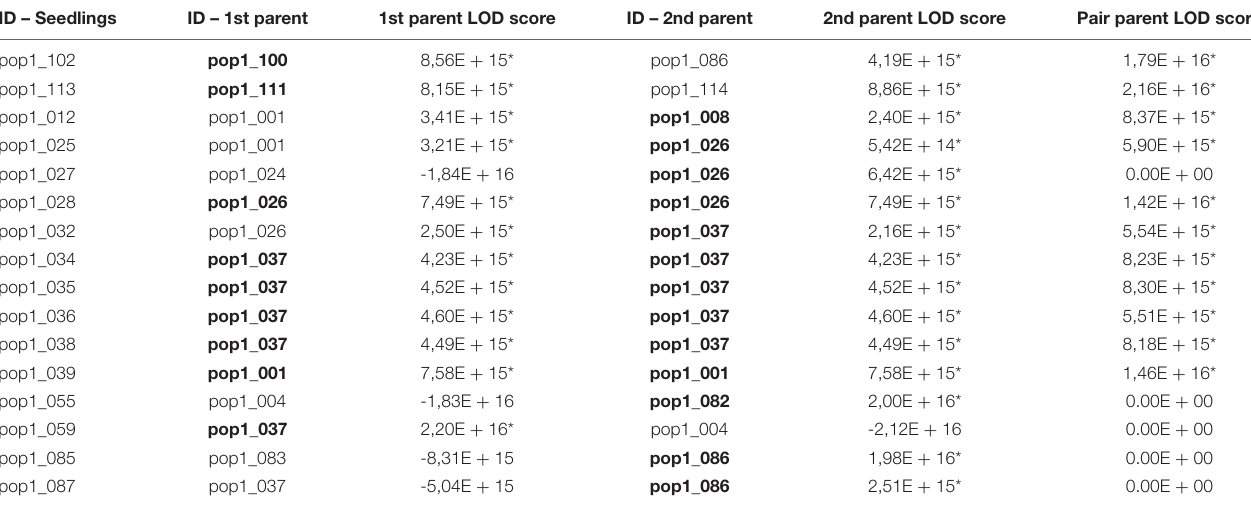
The sampling distribution is shown in Figure 1 . 1 LOD score is the natural logarithm of the likelihood that the candidate parent is the true parent divided by the likelihood that the candidate parent is not the true parent. *Delta criterion based on 95% confidence threshold from 50,000 simulations. Maternal parents are in